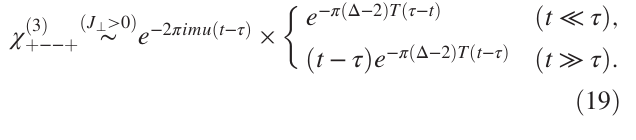
FIG. 4. (a) Nonlinear magnetic susceptibility χ antiferromagnetic chain as a function of π T ð t − τ Þ for π T τ ¼ 50 (blue) and π T τ ¼ 80 (cyan). The waiting time π Tt Luttinger parameter K ¼ 0 . 7 . The data for different τ are rescaled by the same factor such that the maximum of the complex modulus of the π T τ ¼ 50 data is 1. Upper right inset shows the complex modulus of the t > τ part of the data multiplied by exp ð γ j t − τ jÞ with γ ¼ π ð Δ − 2 Þ T . Lower left inset shows the complex modulus of the t < τ part of the data multiplied by exp ð γ j t − τ jÞ . (b) The same as (a) but for K ¼ 1 . (c) The same as (a) but for K ¼ 1 . 5